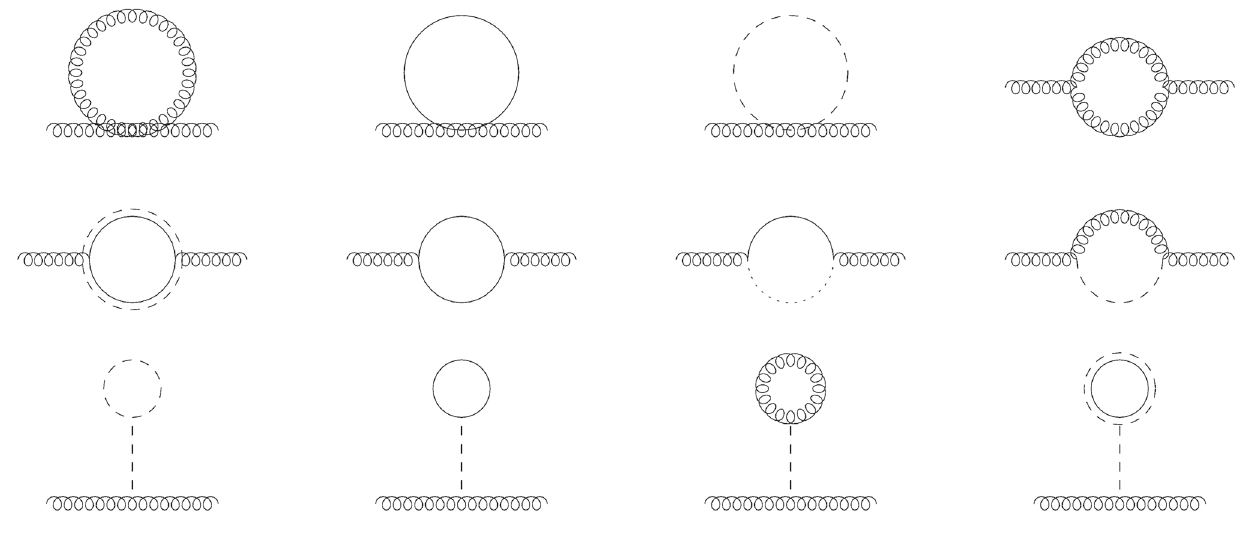
Fig. 9 Contributions to the one-loop gauge field